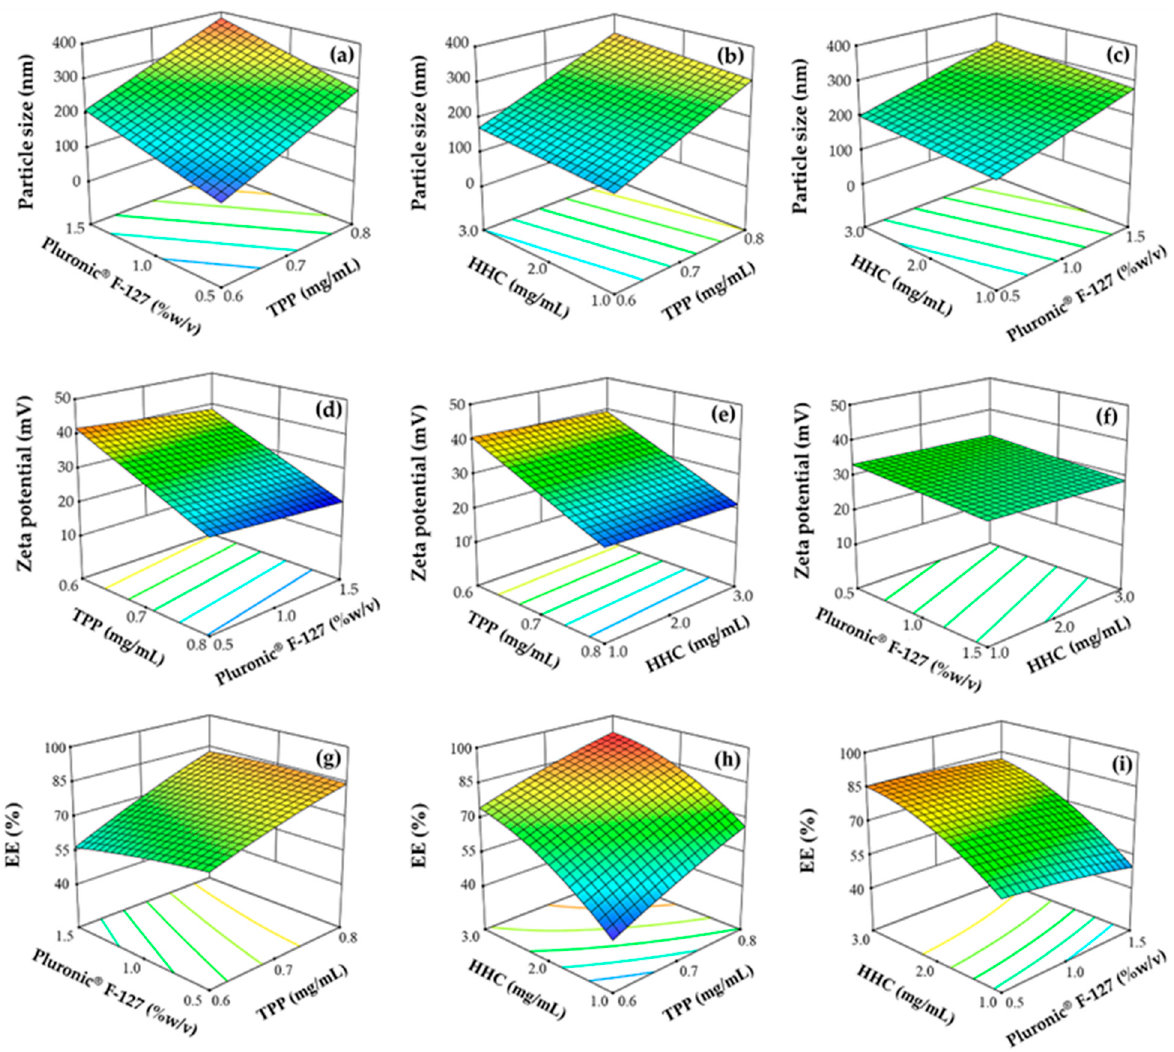
Figure 1. The 3D response surface plot shows the effect of the factors, including TPP, Pluronic® F ‐ 127, and HHC concentrations  on particle size ( a – c ), zeta potential ( d – f ), and EE ( g – i